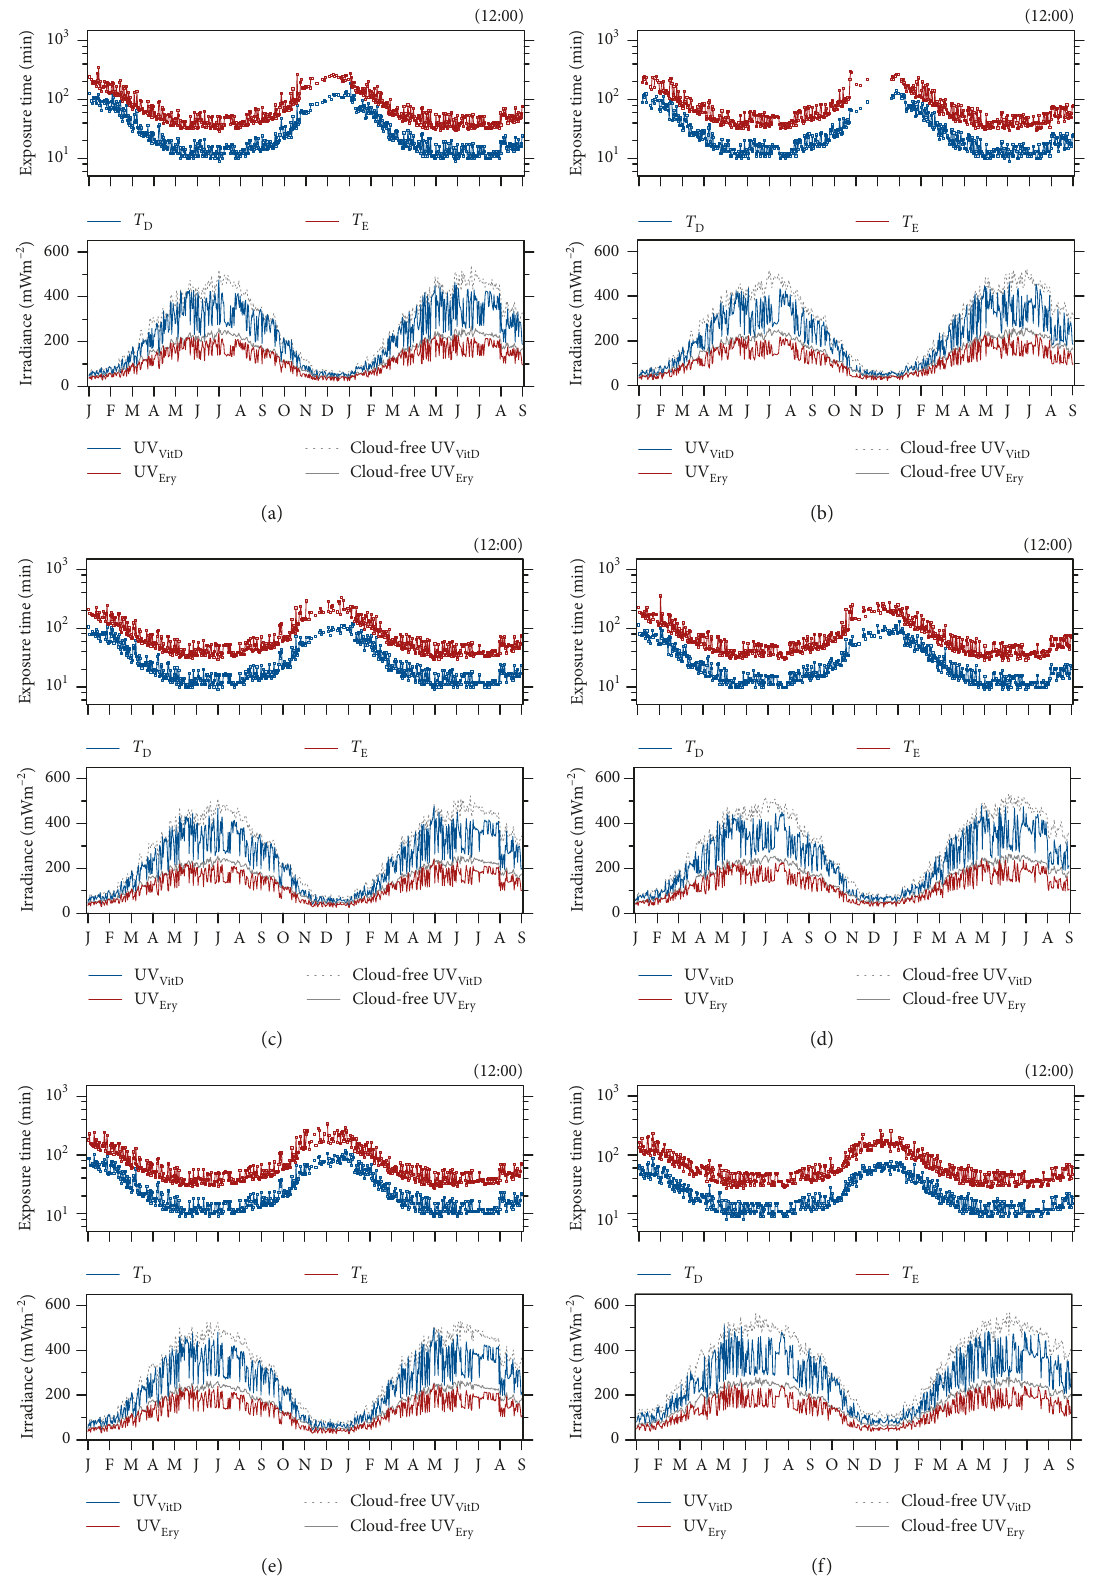
Figure 3: Time series of simulated UV irradiance and threshold exposure time for vitamin D synthesis and erythema dose at noon over (a) Seoul, (b) Gangneung, (c) Anmyeondo, (d) Pohang, (e) Mokpo, and (f)